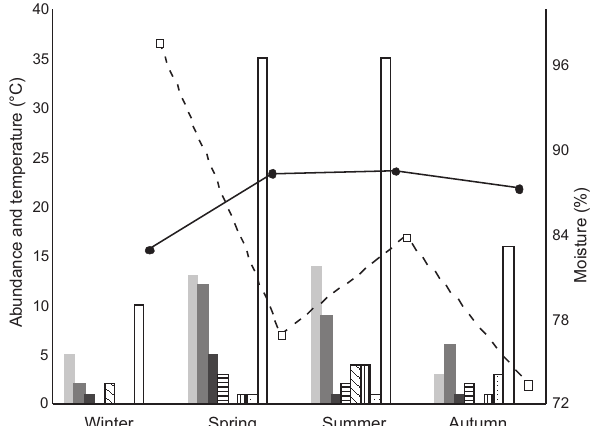
0.Figure 2. Temperature, moisture and abundances (specific and overall) of leaf-litter frogs during the four seasons sampled in the Reserva Natural Salto Morato, Guaraqueçaba. Ischnocnema guentheri = light gray bars, L. marmoratus = gray bars, B. hermogenesi = dark gray bars, P. spiniger = bars with horizontal lines, P. boiei = bars with diagonal lines, H. binotatus = bars with vertical lines, R. abei = bars with points and Overall = white bars. Temperature = solid lines and moisture = dotted